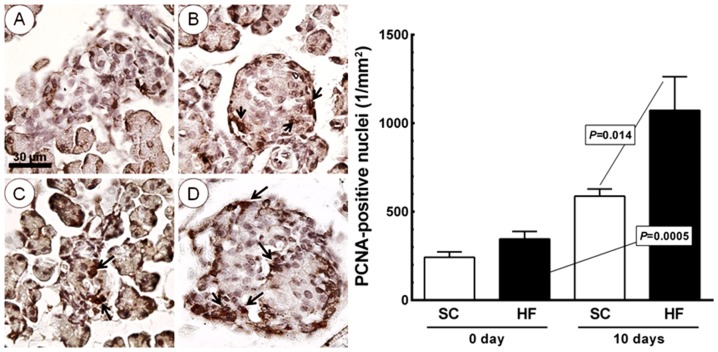
Offspring islets on the day of birth (A, SC group; C, HF group) and at 10 days of age (B, SC group; D, HF group) immunostained with anti-proliferating cell nuclear antigen (PCNA) (arrows, same magnification for all pictures).
Right side: bar graph of PCNA density per area in the islet (mean and standard error of the mean). Significant differences are indicated (one-way ANOVA and post-hoc Holm-Sydak test). Abbreviations: SC, standard chow group; HF, high fat diet group.